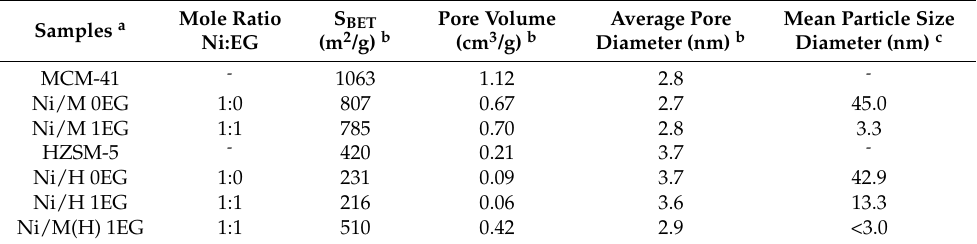
Table 1. Physicochemical characteristics of the